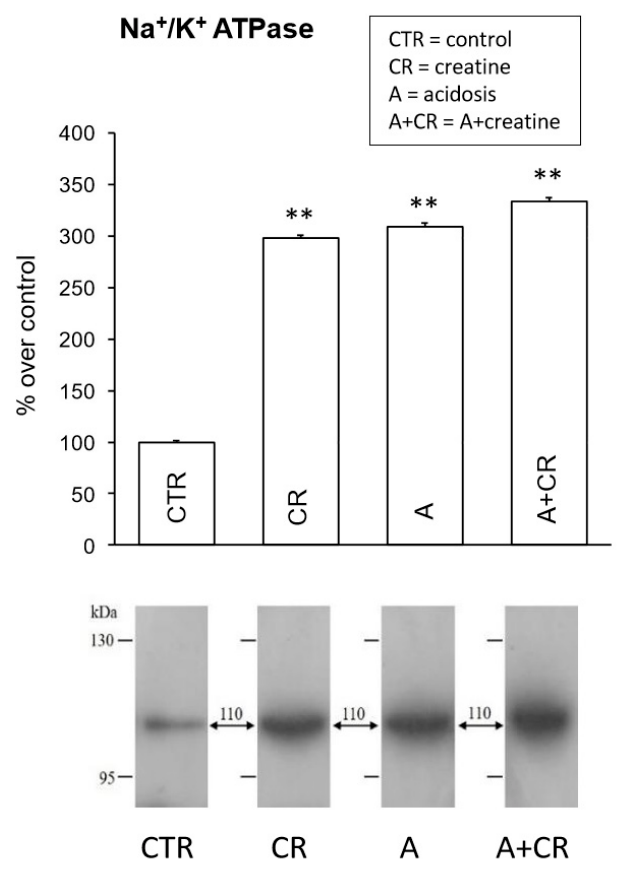
Figure 6. Effects of 11 d administration of 20 mM creatine on Na + /K + -ATPase expression in jejunal mucosal homogenates under control conditions and chronic acidosis. Western blot analysis for Na + /K + -ATPase was performed on jejunum total proteins and was carried out on 4 experiments. Densitometric analysis of the bands revealed a significant statistical difference in the intensity of the signals. ** p ≤ 0.05 vs. control.